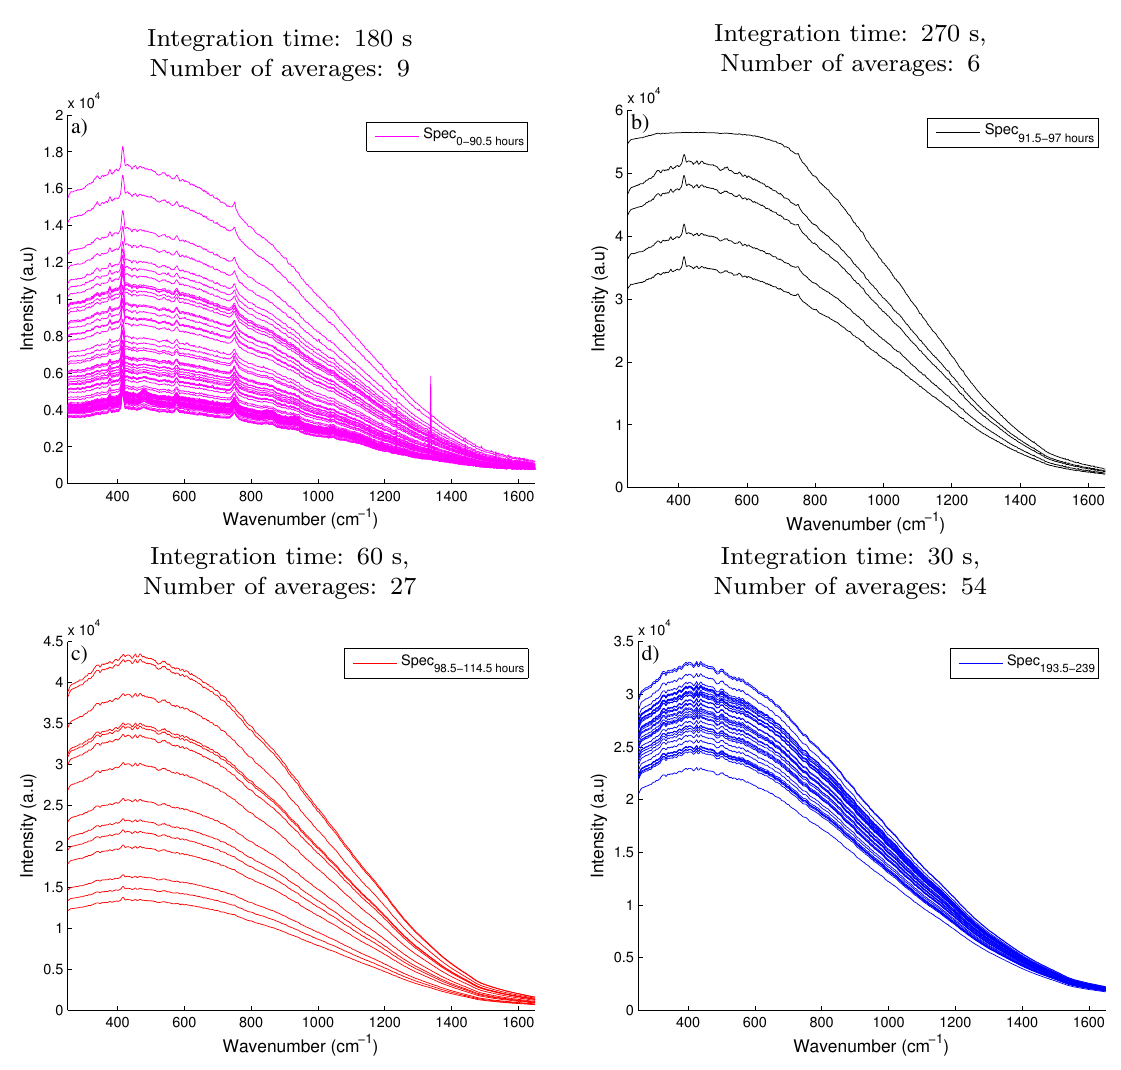
Figure 2. A subset of the raw spectra recorded by the 903 nm Raman spectroscopic device collected at different tuning parameters with ( a ) recorded using an integration time of 180 s and taking 9 averages over the time course of the fermentation from 0–90.5 h; ( b ) had an integration time of 270 s and 6 averages over the time course of 91.5–97 h; ( c ) had an integration time of 60 s and 27 averages over the time course of 98.5–114.5 h and ( d ) was recorded using an integration time of 30 s and 54 averages over the time course of 193.5–239 h. Table 1. Summary of tuning parameters chosen for the 993 and 903 nm Raman throughout each batch.